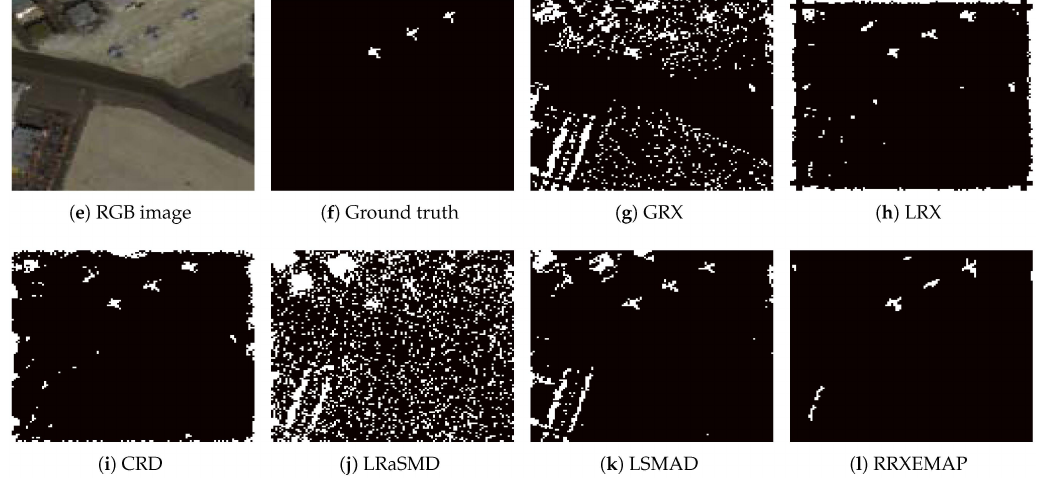
Figure 6. Color detection maps obtained by different algorithms for the AVIRIS-I dataset.